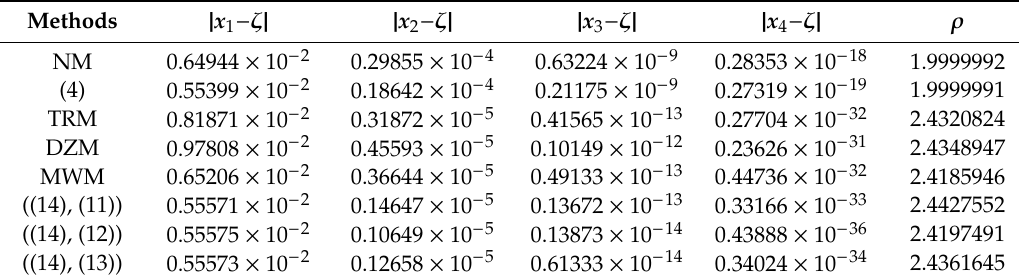
Table 10. Numerical results for function f 10 ( x )